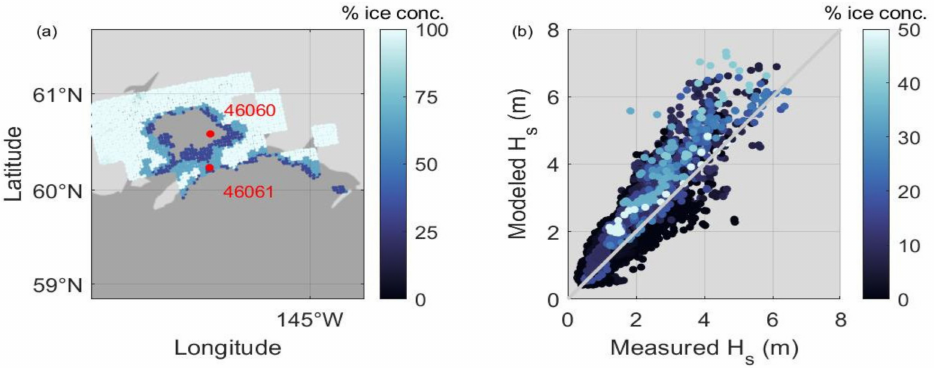
Figure 2. ( a ) Example of ice concentrations around PWS as measured with the AMSR2 instrument on 7 December 2017. Both sea ice and land ice are shown. Red circles indicate the locations of wave buoy 46060 inside PWS and 46061 near the mouth. ( b ) Comparison of the modeled significant wave height, H s , and the measured H s at buoy 46061 during 2017 (data from